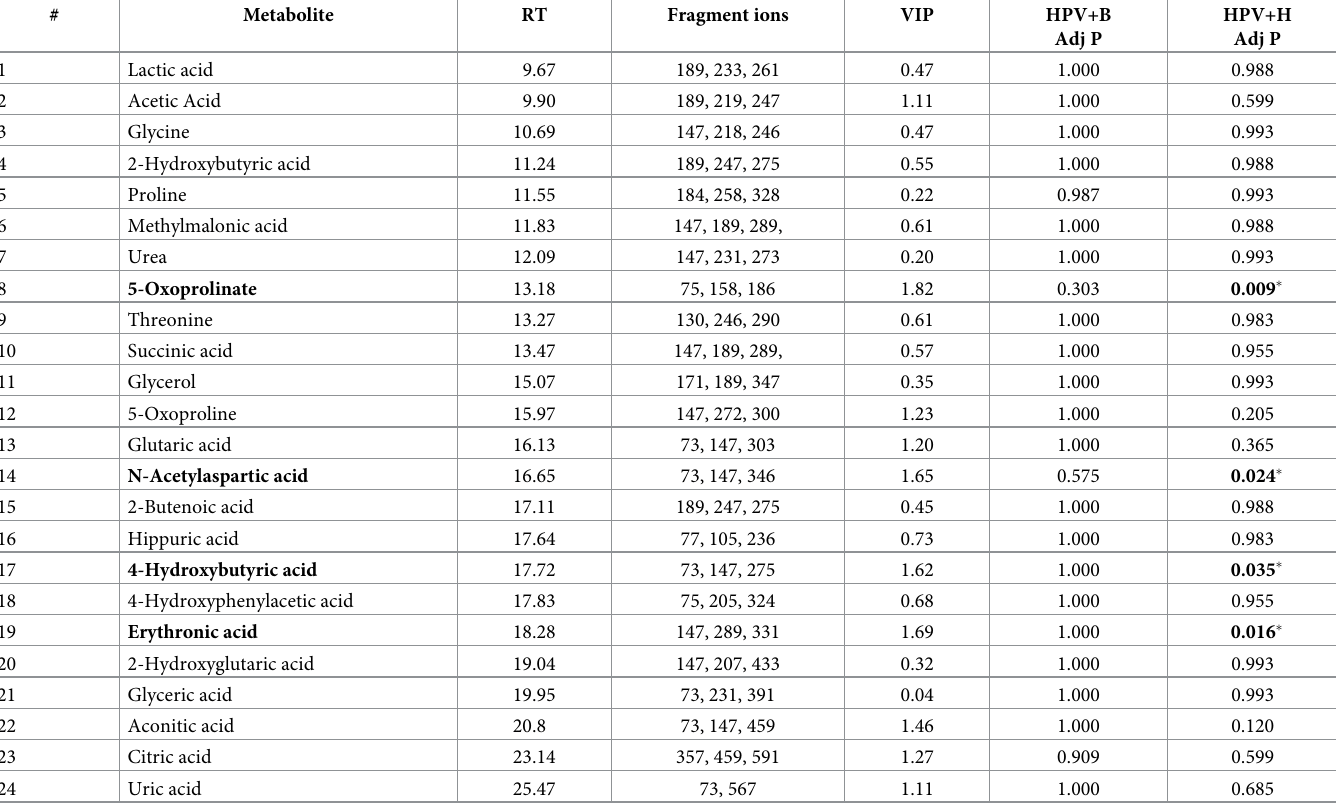
Table 2. Human urine metabolome found in HPV+B vs HPV- and HPV+H vs HPV-